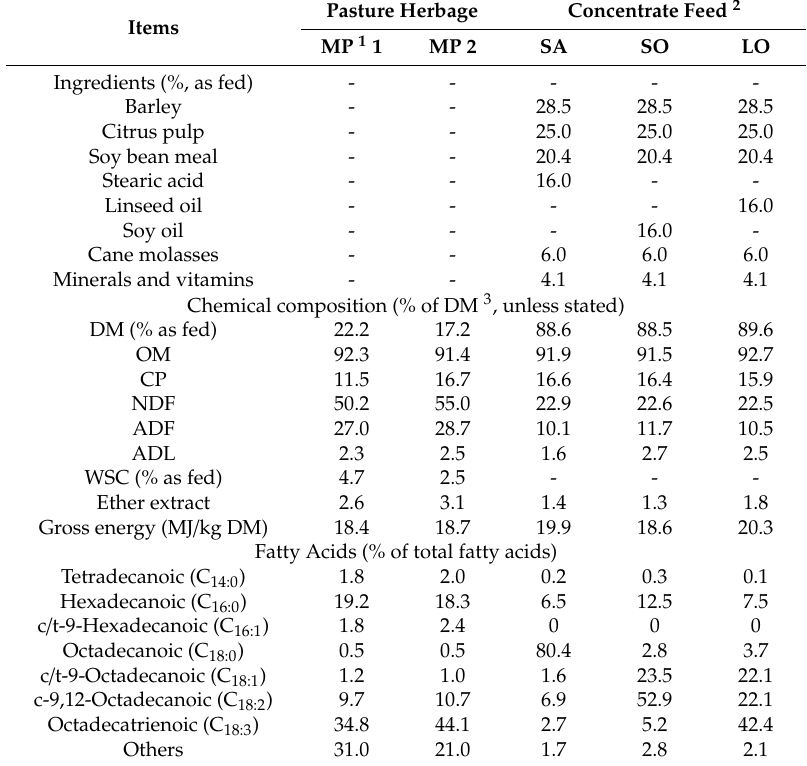
Table 1. Concentrate ingredients and chemical and fatty acid composition of the concentrates and pasture o ff ered. Pasture Items